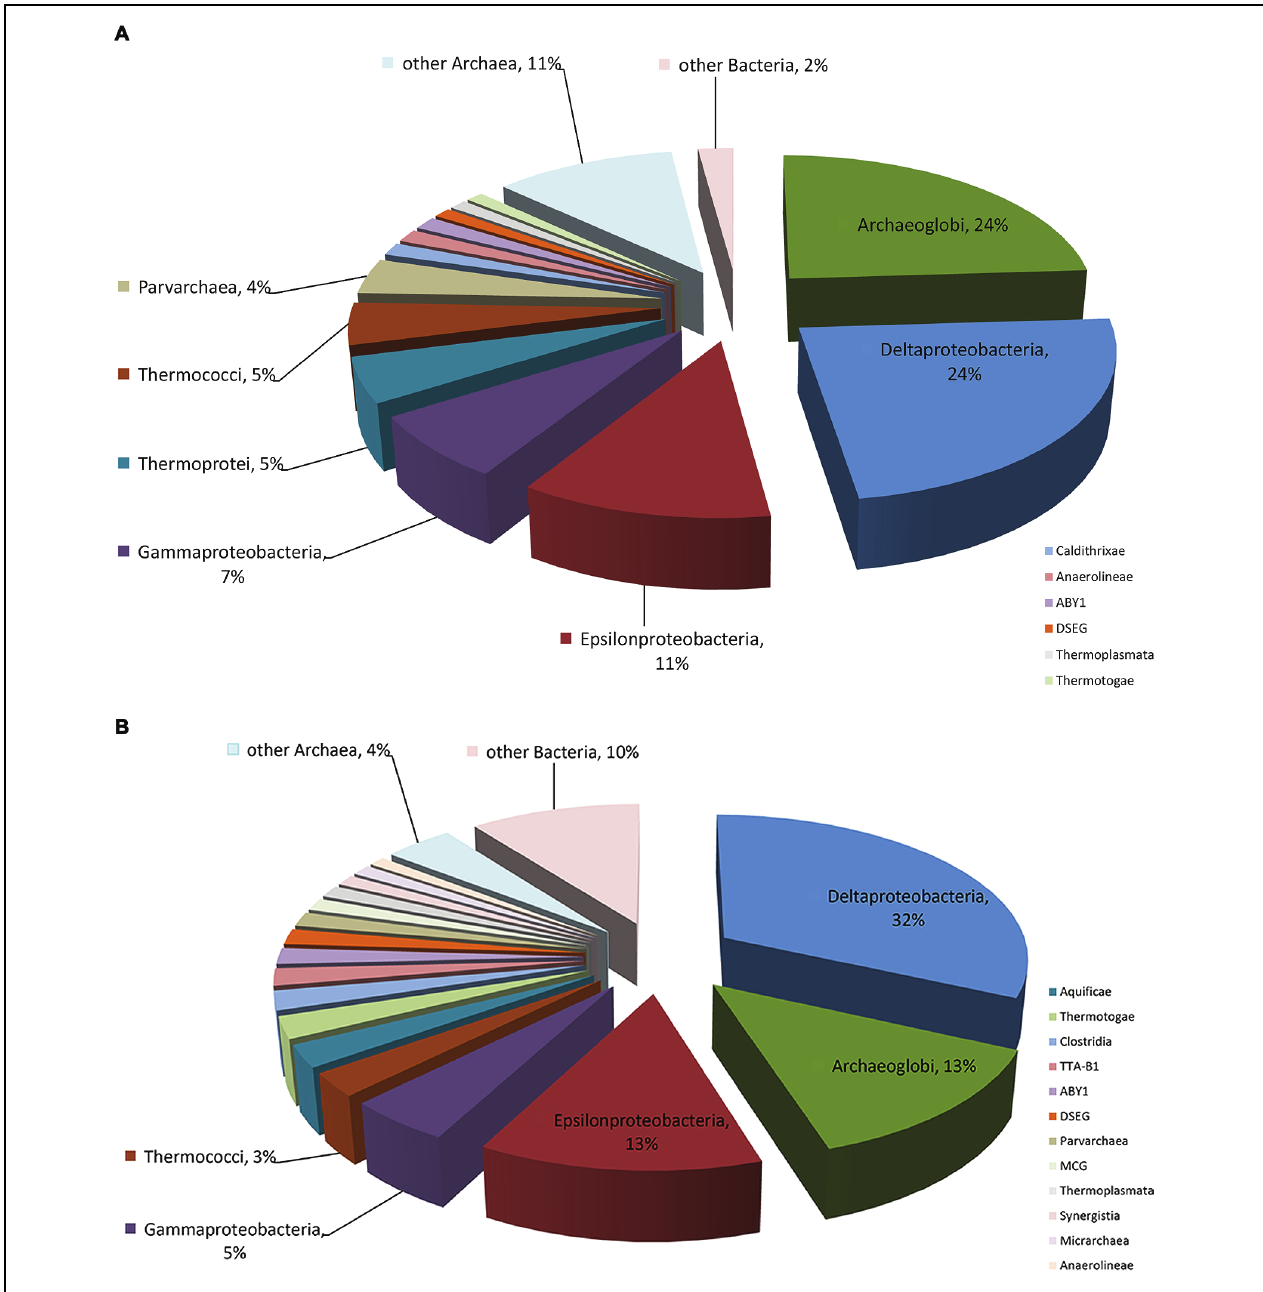
FIGURE 1 | Microbial composition of the enriched AOM-SR community. Detailed information is displayed in Table 1 . (A) Percentage of the microbial community determined from the 16S rRNA gene sequences retrieved from the metagenome. (B) Percentage of the microbial community determined from the 16S rRNA gene sequences retrieved from the